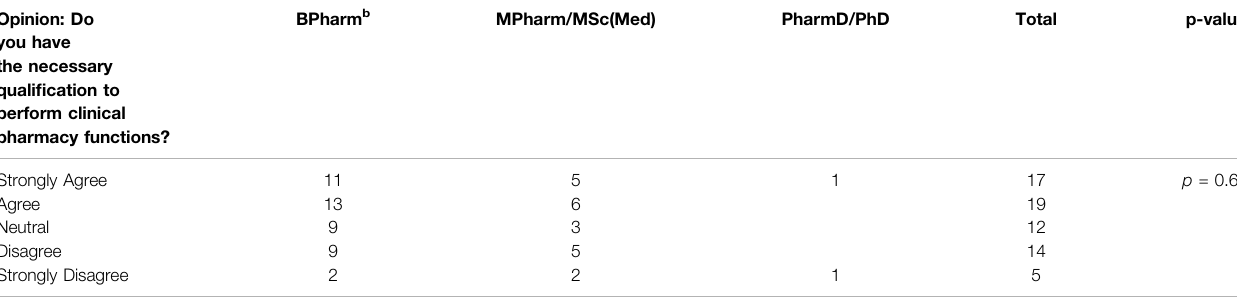
TABLE 3 | Opinion on Quali fi cation compared to Quali fi cation.